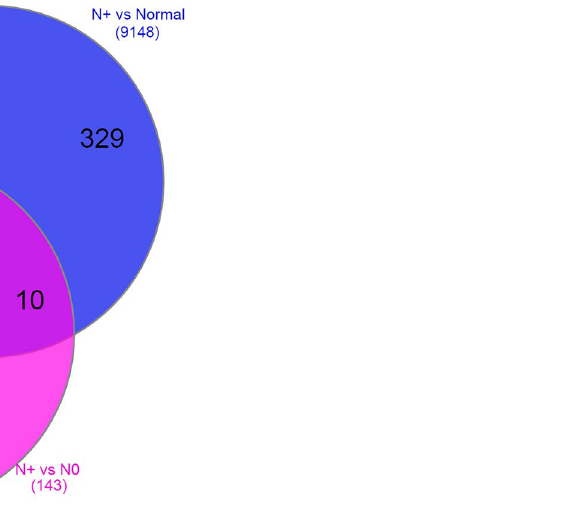
Figure 3. Identification of dedicated and overlapping down-regulated DEGs related to N + and N0 conditions.